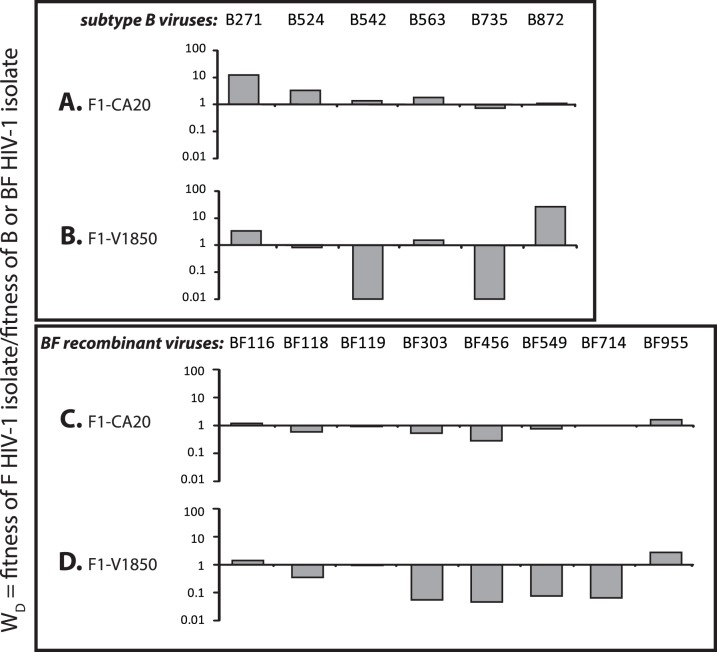
Comparing the relative replicative fitness difference (WD) of HIV-1 sub-subtype F1 reference strains; (a) CA20 and (b) V1850 and Argentinean subtype B (B271, B524, B542, B563, B735 and B872) in direct competitions using PHA/IL2 PBMCs.Similarly, subtype F (c) CA20 and (d) V1850 were competed against BFs (BF116, BF118, BF119, BF303, BF456, BF549, BF714 and BF955). Bars represent the relative fitness of the viruses shown on the Y-axis.